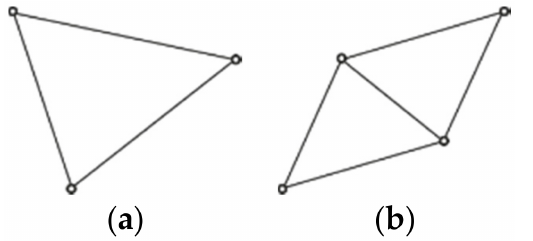
Figure 4. The triangle ( a ) and square with a diagonal ( b ), which are both fixed-shaped clusters.